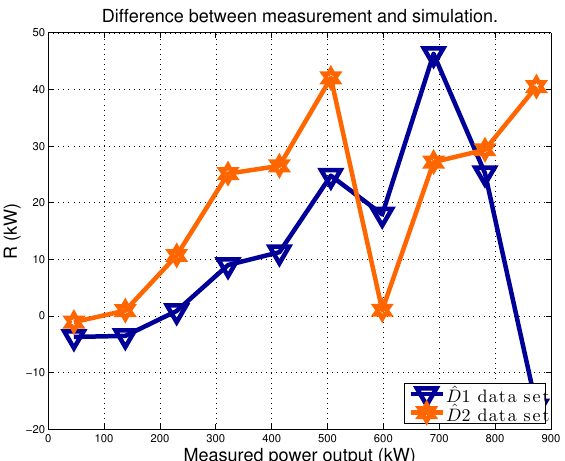
Figure 11. The average difference R between power measurement y and estimation ˆ y (Equation (11)). Datasets: D1 and D2. Sample run of the